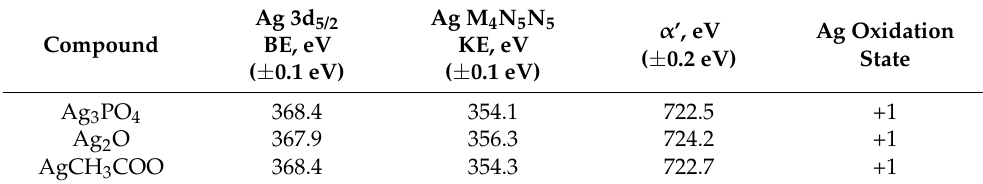
Table 2. Values of Ag 3d 5/2 (in BE), Ag M 4 N 5 N 5 (in KE), Auger parameter and corresponding silver oxidation state for the reference samples of Ag